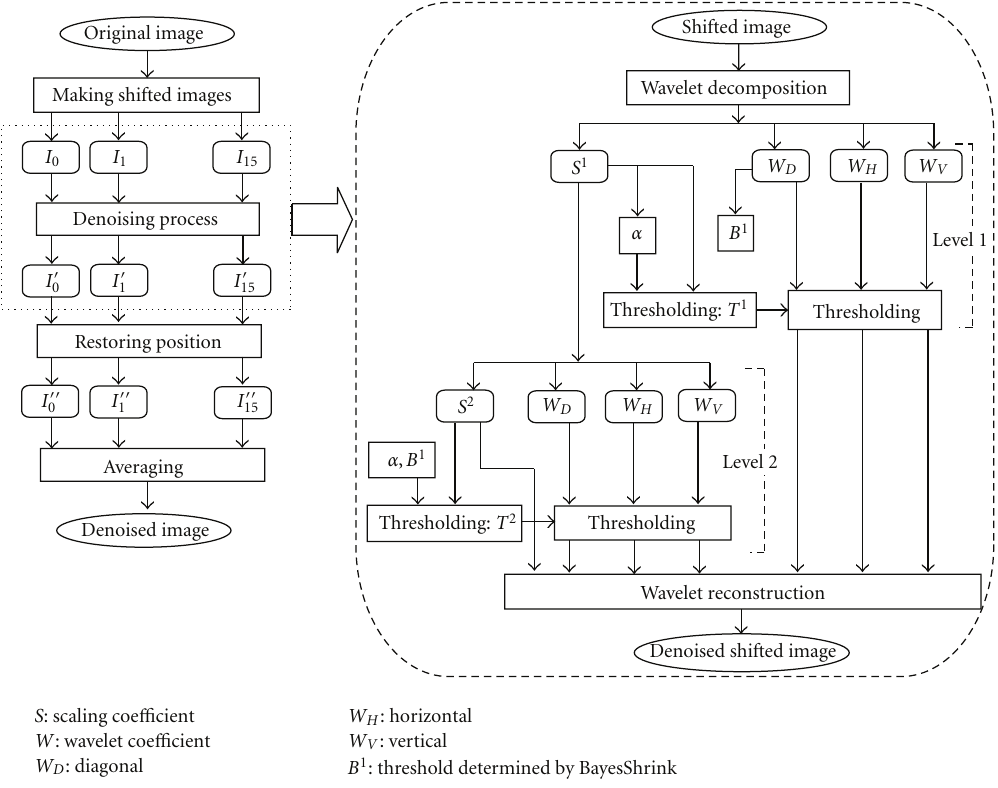
Figure 1: Flowchart of the proposed method. In this figure, the decomposition was performed up to level 2, but actually we decomposed to level 3.